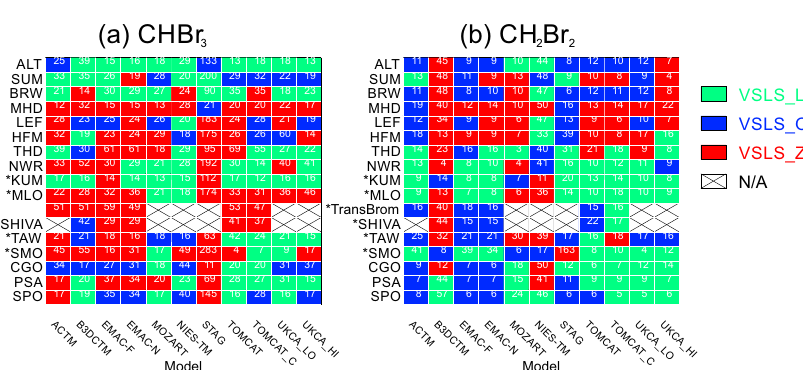
Figure 6. Summary of agreement between model (a) CHBr 3 and (b) CH 2 Br 2 tracers and corresponding surface observations (ground-based; see Table 3, and TransBrom/SHIVA ship cruises). The fill colour of each cell (see legend) indicates the tracer giving the best agreement for that model, i.e. the lowest mean absolute percentage error (MAPE, see main text for details), and the numbers within the cells give the MAPE value (%), for each model compared to the observations. CHBr 3 _L tracer used the Liang et al. (2010) emissions inventory, CHBr 3 _O tracer used Ordóñez et al. (2012) and CHBr 3 _Z tracer used Ziska et al. (2013). Sites marked with ∗ are tropical locations. Certain model–measurement comparisons are not available (N/A).